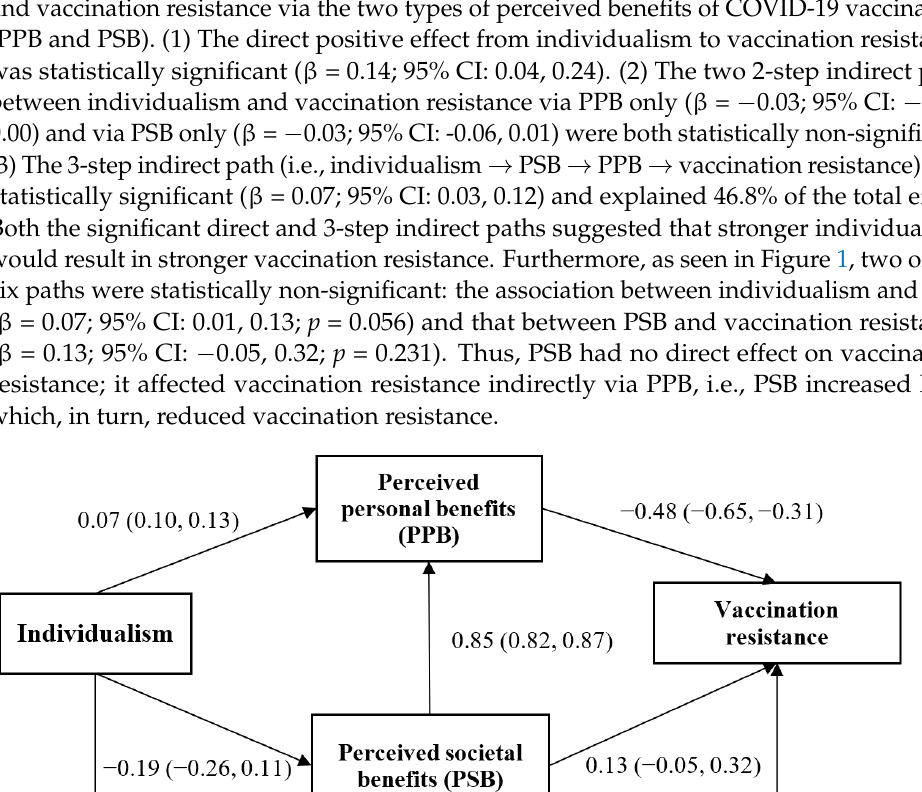
Table 2. Factors of vaccination resistance (n = 395)